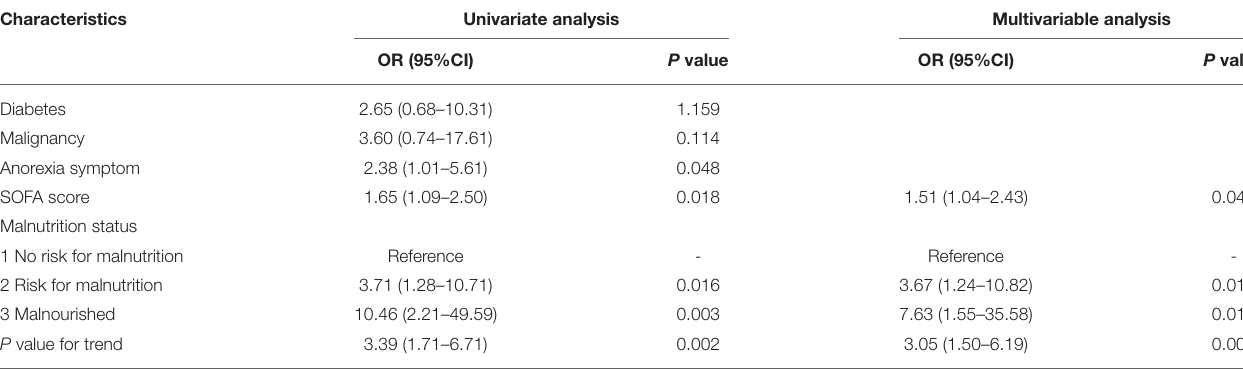
TABLE 2 | Multivariate logistic regression analysis of the risk factors for low TLC in hospitalized patients with early-stage